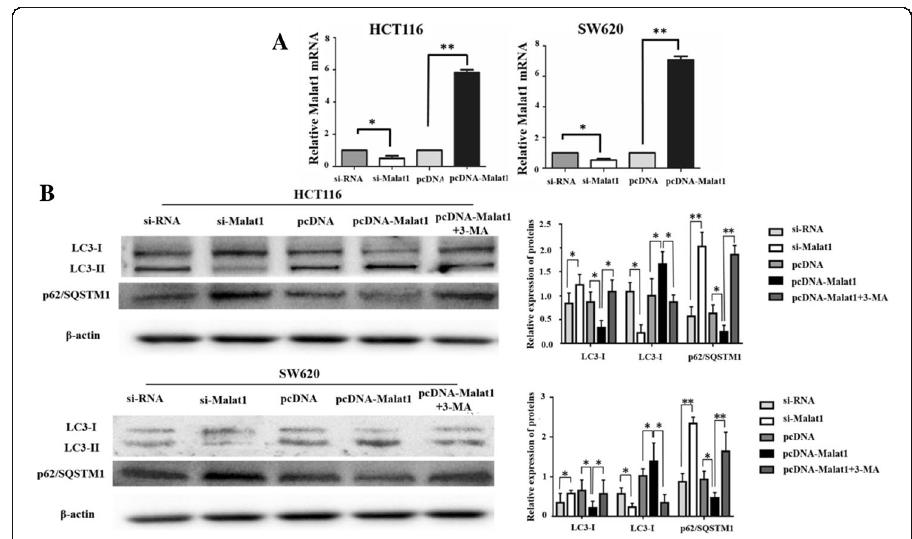
Fig. 2 Abnormal expression of Malat1 activates autophagy in CRC. a qRT-PCR assay shows Malat1 level in HCT116 and SW620 cells transfected with si-RNA, si-Malat1, pcDNA, pcDNA-Malat1 or pcDNA-Malat1+3-MA. b Western blot assay shows the effects of Malat1 downregulation or upregulation on LC3-II/Iand p62/SQSTM1 expression in HCT116 and SW620 cells. The columns show the mean for three separate experiments. * p <0.05, ** p